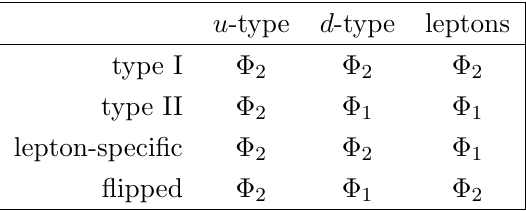
Table 1 . The four Yukawa types of the Z 2 -symmetric 2HDM de(cid:12)ned by the Higgs doublet that couples to each kind of